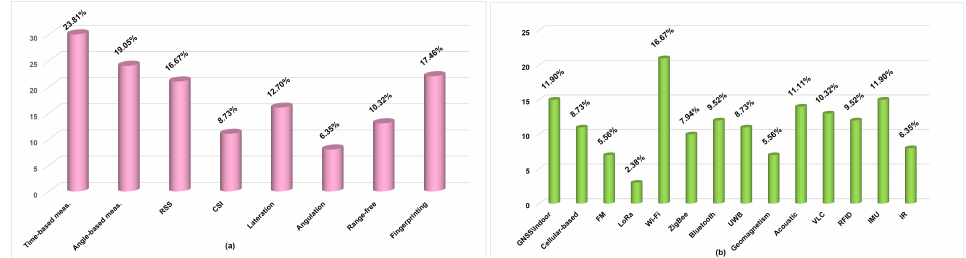
Figure 19. Statistical analysis of the reviewed literature, with respect to: ( a ) Localization techniques, and ( b ) Wireless technologies.